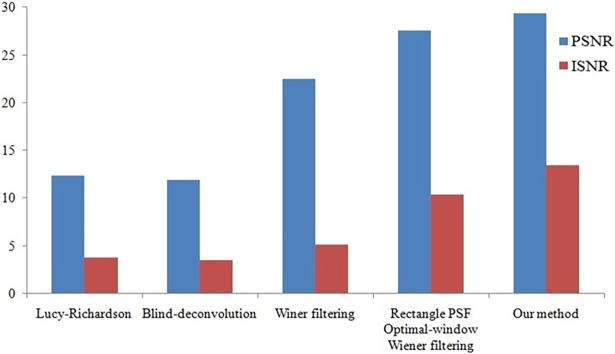
Evaluation of different fusion methods of Fig 5.